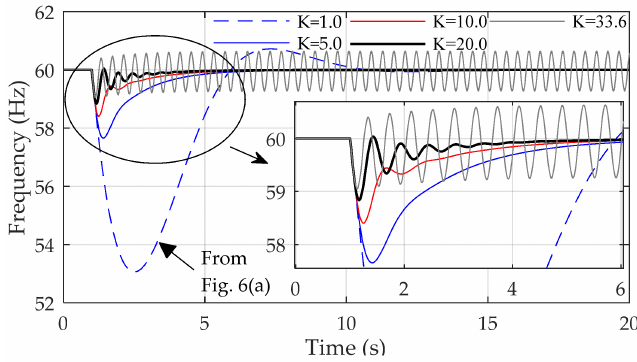
Figure 14. Effect of increasing K on the frequency recovery process of the